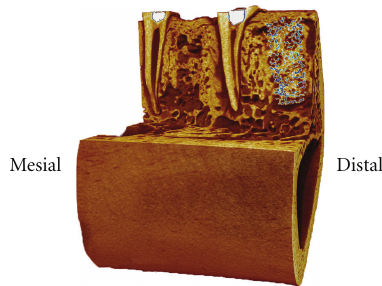
Figure 2: Representative three-dimensional illustration of the sca ff old (right) and sham (left) sites with their corresponding mesial roots after six weeks of healing (reconstructed from micro-CT data using